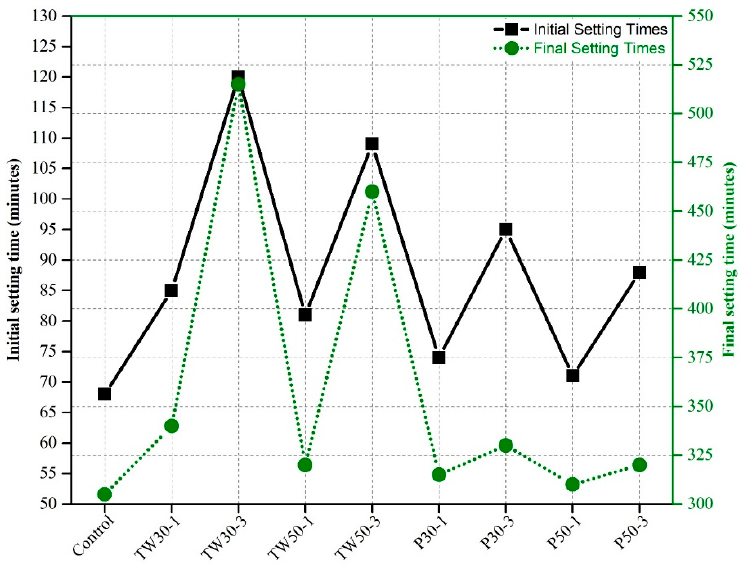
Figure 4. Initial and final setting times of specimens.